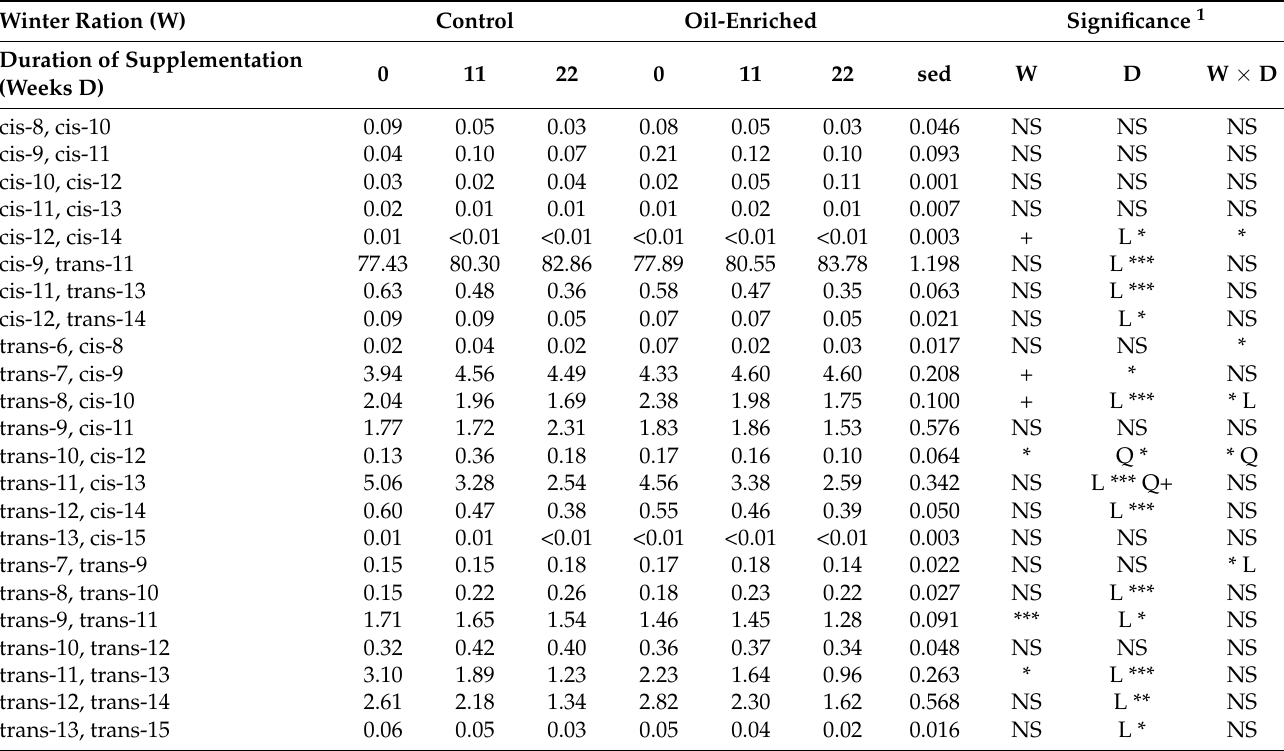
Table 4. The conjugated linoleic acid (CLA) isomer profile (g/100 g CLA) in longissimus muscle of beef